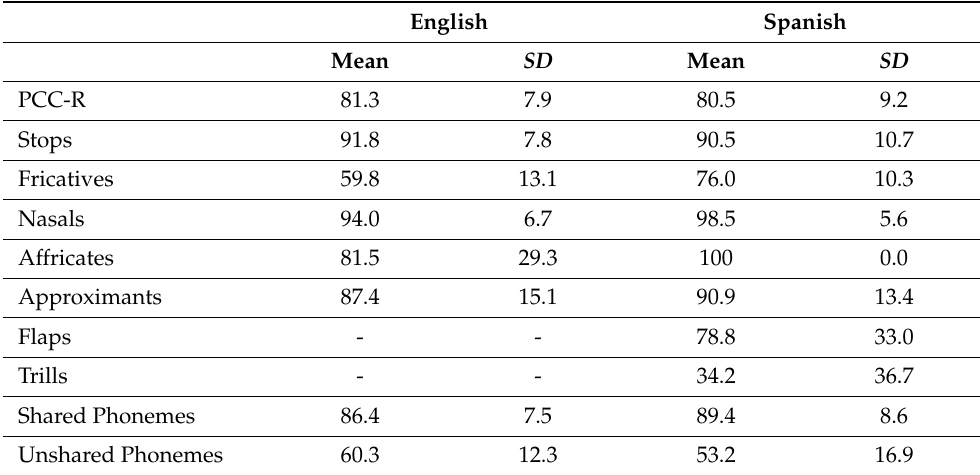
Table 1. Children’s phonological accuracy in English and Spanish for all consonants (PCC-R), for different sound classes, and for shared and unshared phonemes (in %). English